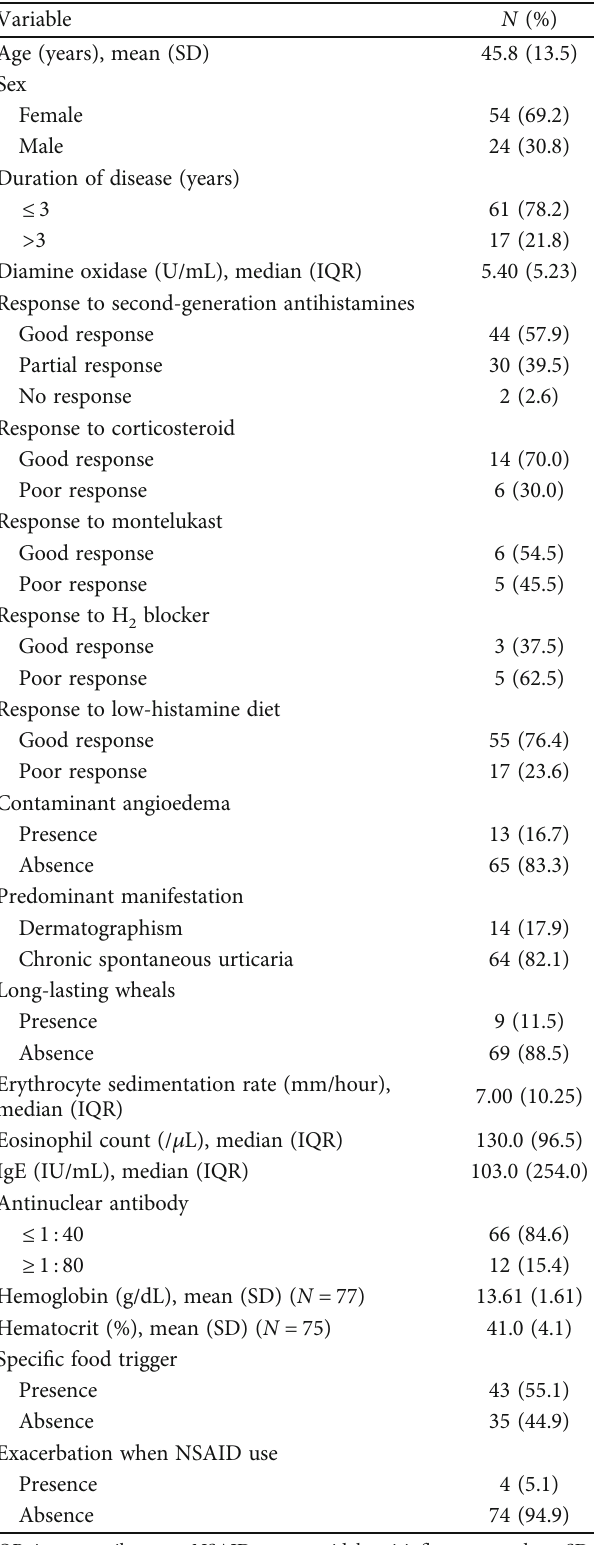
Table 1: Characteristic of patients with chronic urticaria ( N = 78 ). Table 2: Univariate analyses of mean diamine oxidase level in patients with chronic